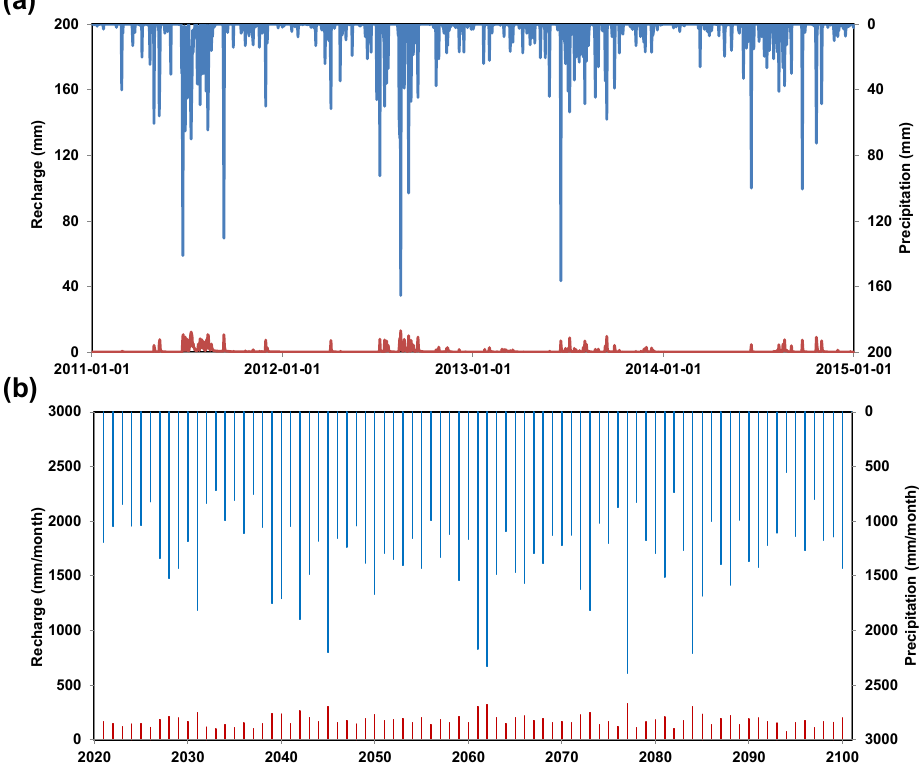
Figure 7. Comparison between estimated recharge (red line) and precipitation (blue line) for ( a ) validated daily recharge data (modified from Chang and Chung [43]) and ( b ) future annual precipitation and recharge scenario based on RCP 4.5.